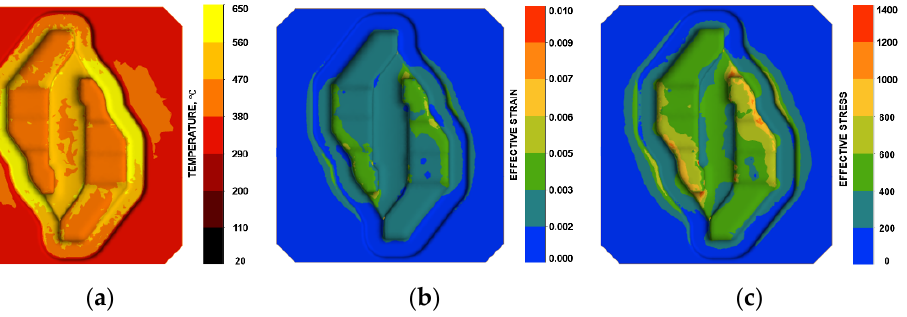
Figure 11. Tool working surface: distribution of ( a ) temperature, ( b ) effective strain, and ( c ) effective stress .